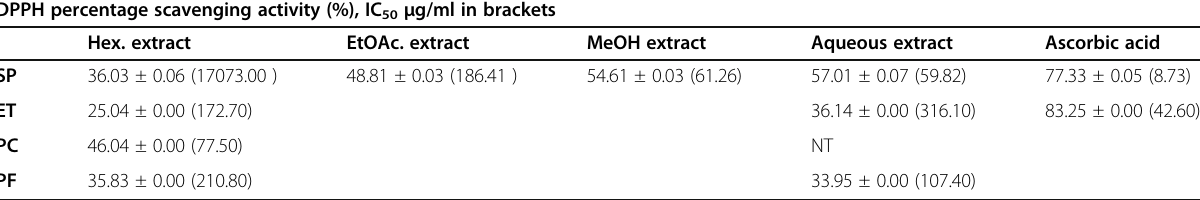
Table 3 DPPH percentage scavenging activity of the crude extracts of the four plant extracts DPPH percentage scavenging activity (%), IC 50 μ g/ml in brackets Hex. extract